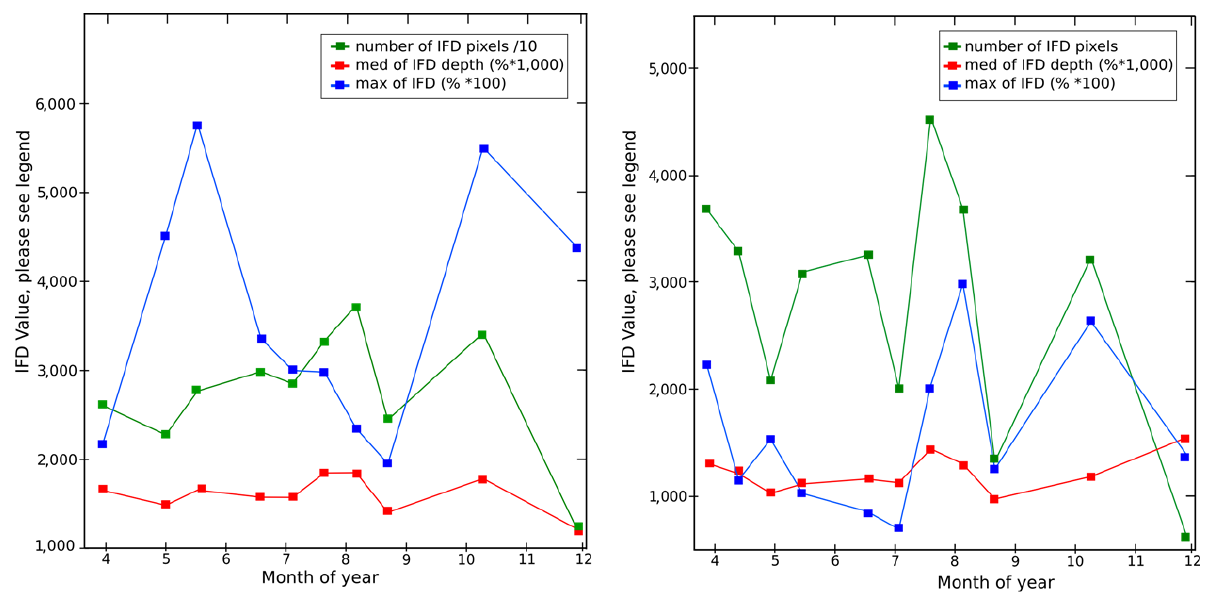
Figure 12. Multi-temporal iron feature depth (IFD) data from the tailings facilities near GaLuka, Rustenburg ( left ) and from the tailings in Stilfontein ( right ), calculated from the multispectral OLI data scenes listed in Table A1. The high number of IFD pixels in the dry season, July–September, could be attributed to sparser vegetation cover during that time. Please note that the trend in the number of IFD pixels in Rustenburg (left) is similar to the trend in the number of IFD pixels in Klerksdorp (right). A similar observation can be made for the median of the IFD depth between the two